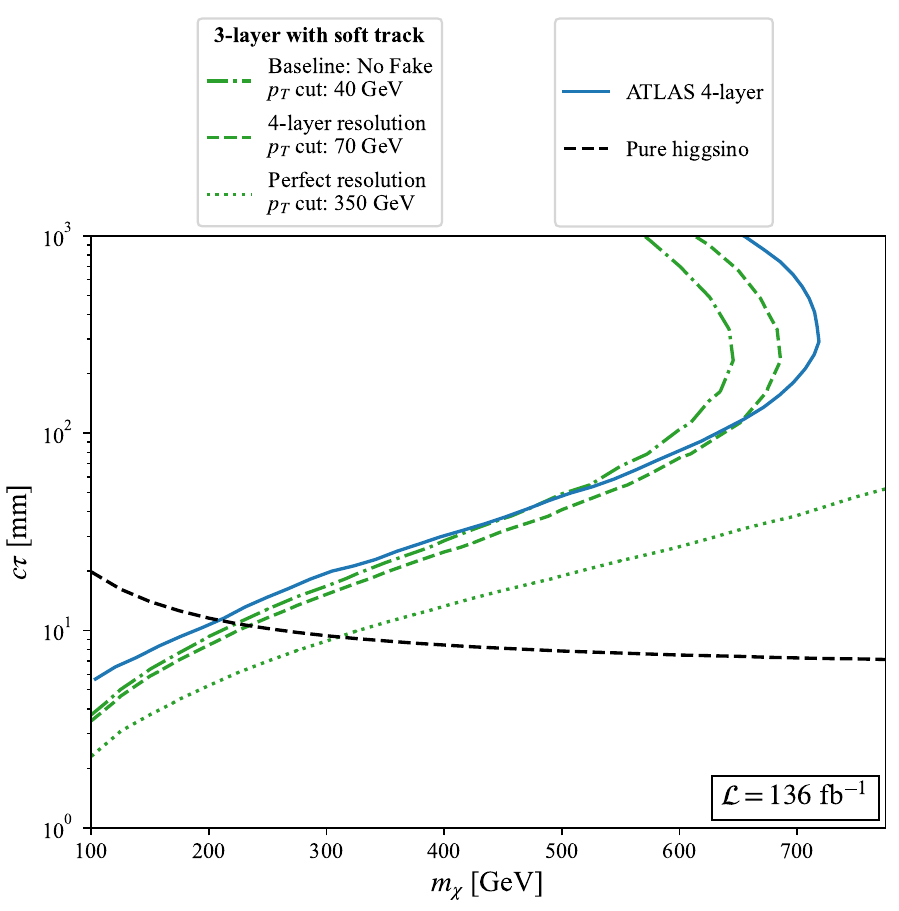
Figure 11 . We illustrate the effect of the chargino p T resolution on the reach of the 3-layer tracklet search with a soft track requirement, for an integrated luminosity of 136 fb − 1 . The solid blue and dot-dashed green curves are the same as in figure 9. The dashed green curve is obtained from the dot-dashed green one by reverting to the p T resolution of 4-layer tracklets, and the dotted green curve is obtained by assuming perfect p T resolution. The optimal value of the chargino p T cut used to obtain each curve is listed in the